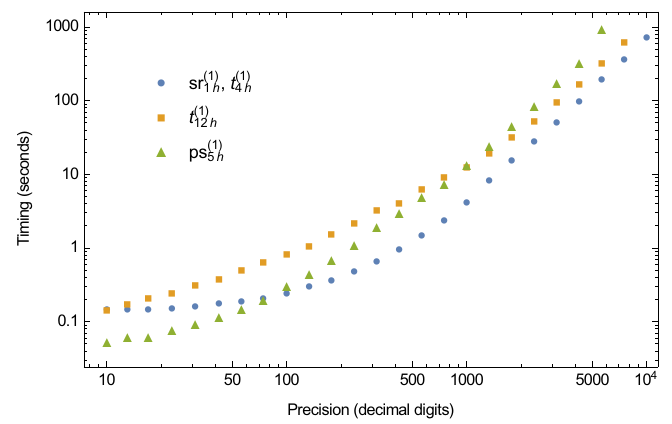
Figure 5 . Calculation times of the homogeneous solutions found in the present